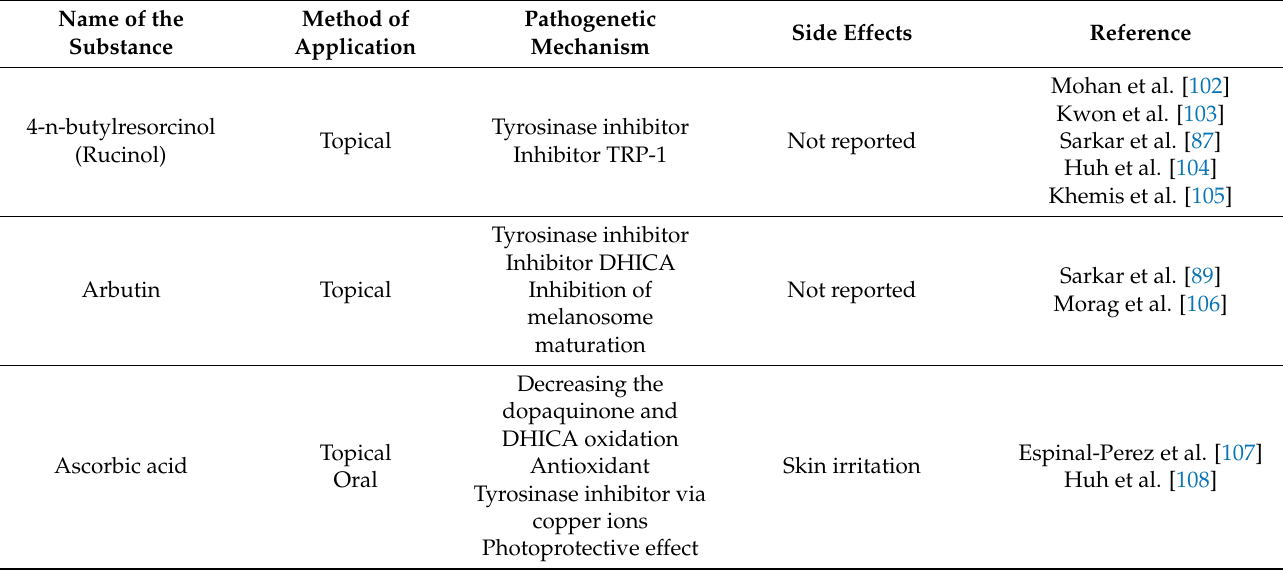
Table 1. Summary of topical therapies in melasma and the pathogenetic pathways they